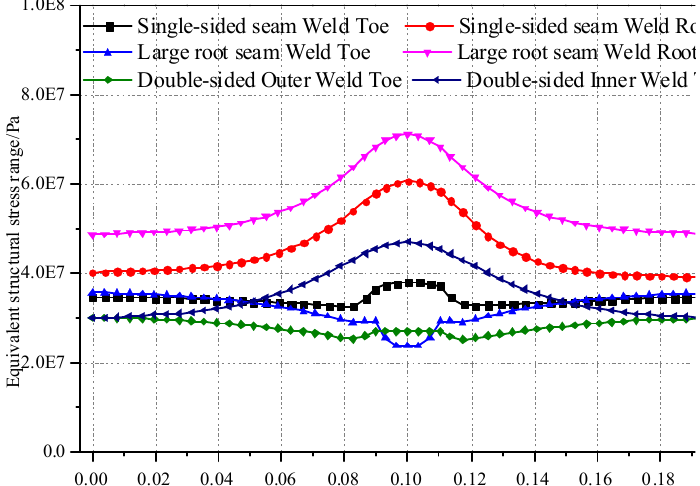
Figure 16. Equivalent structural stress of weld seams of bridge deck with various weld seams.